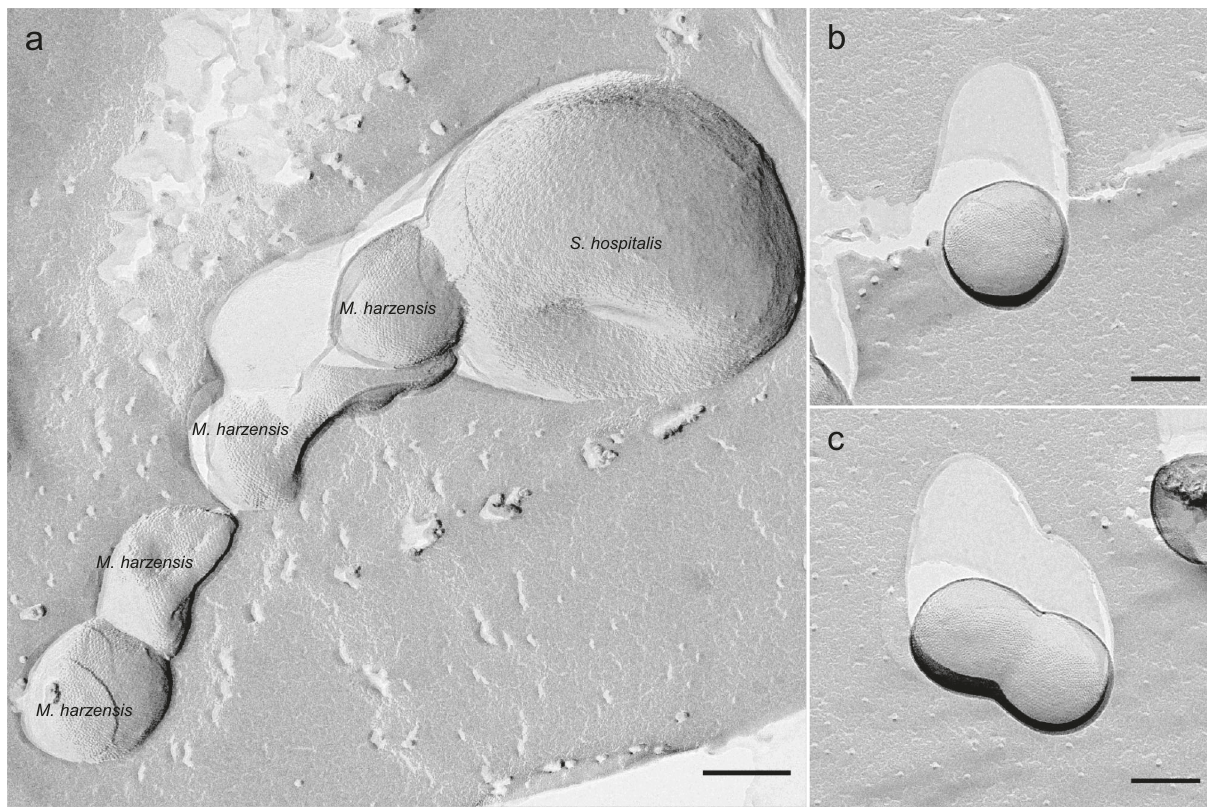
Fig. 7 Electron micrographs of freeze-etched, Platinum-Carbon shadowed co-culture cells, containing Ca . Schef fl eriplasma hospitalis and Ca . Micrarchaeum harzensis. Ca . Micrarchaeum harzensis cells, displaying an S-layer on their surface, were observed ( a ) in physical contact with Ca . Schef fl eriplasma hospitalis cells, as well as ( b ) free living and ( c ) undergoing cell division. Scale bars equal 200 nm. The freeze-etching experiment was repeated once, each time micrographs showing more than 100 cells were